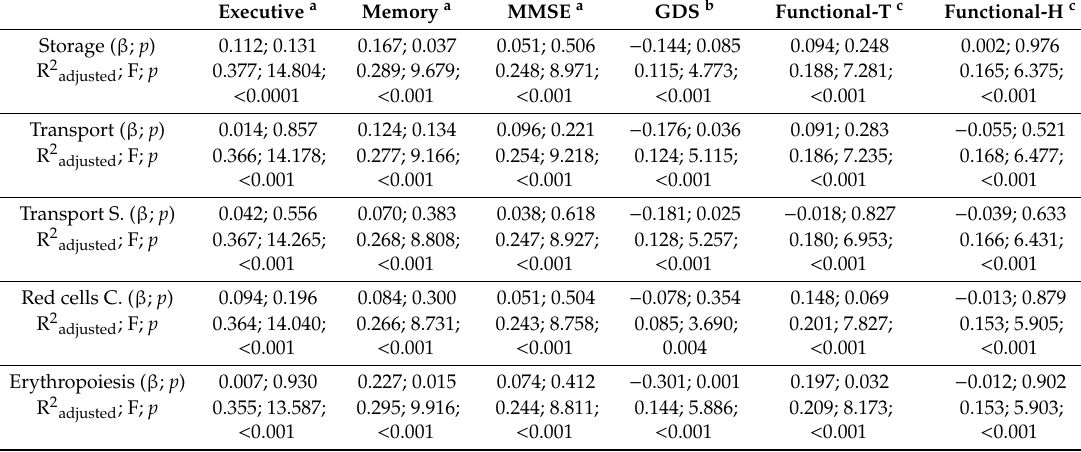
Table 2. Hierarchical regression models for hematological dimensions predicting cognition, mood and physical functional ability based on hematological dimensions.